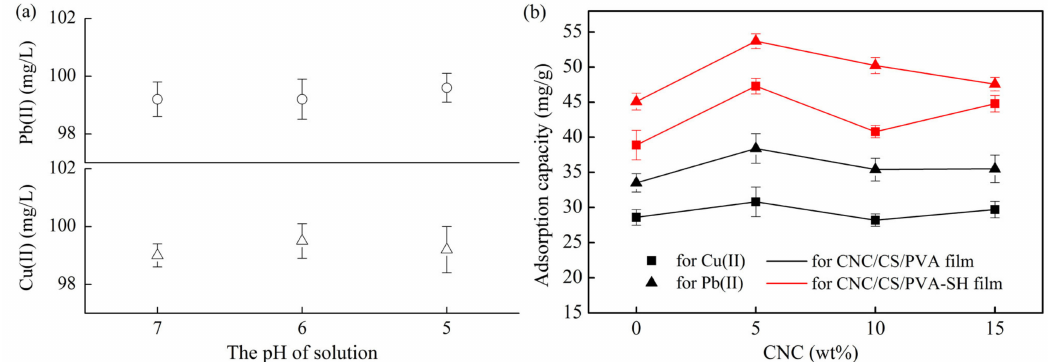
Figure 6. ( a ) M(II) concentration (100 mg/L) curves as a function of pH; ( b ) Adsorption capacity of x CNC/CS/PVA and x CNC/CS/PVA-SH composite nanofibrous